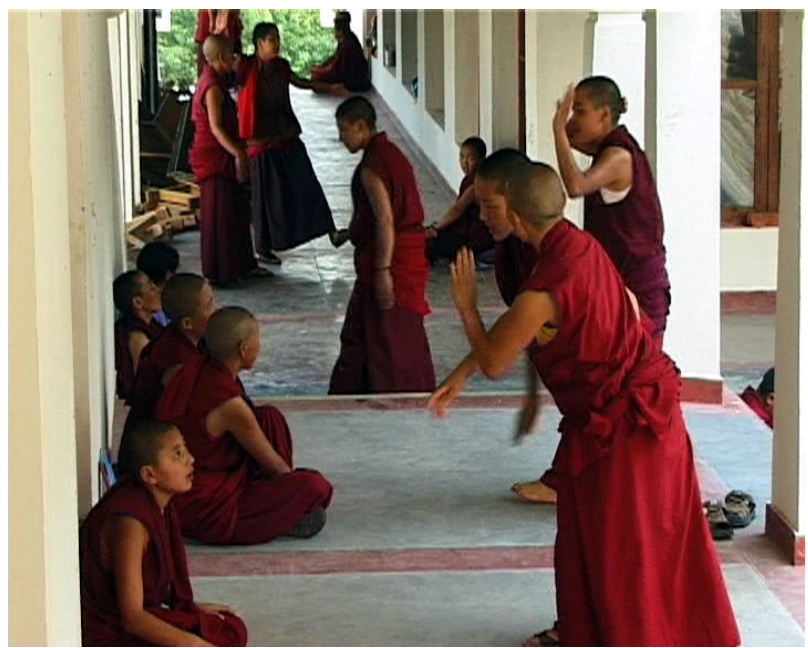
Figure 2. Debate training in Dolma